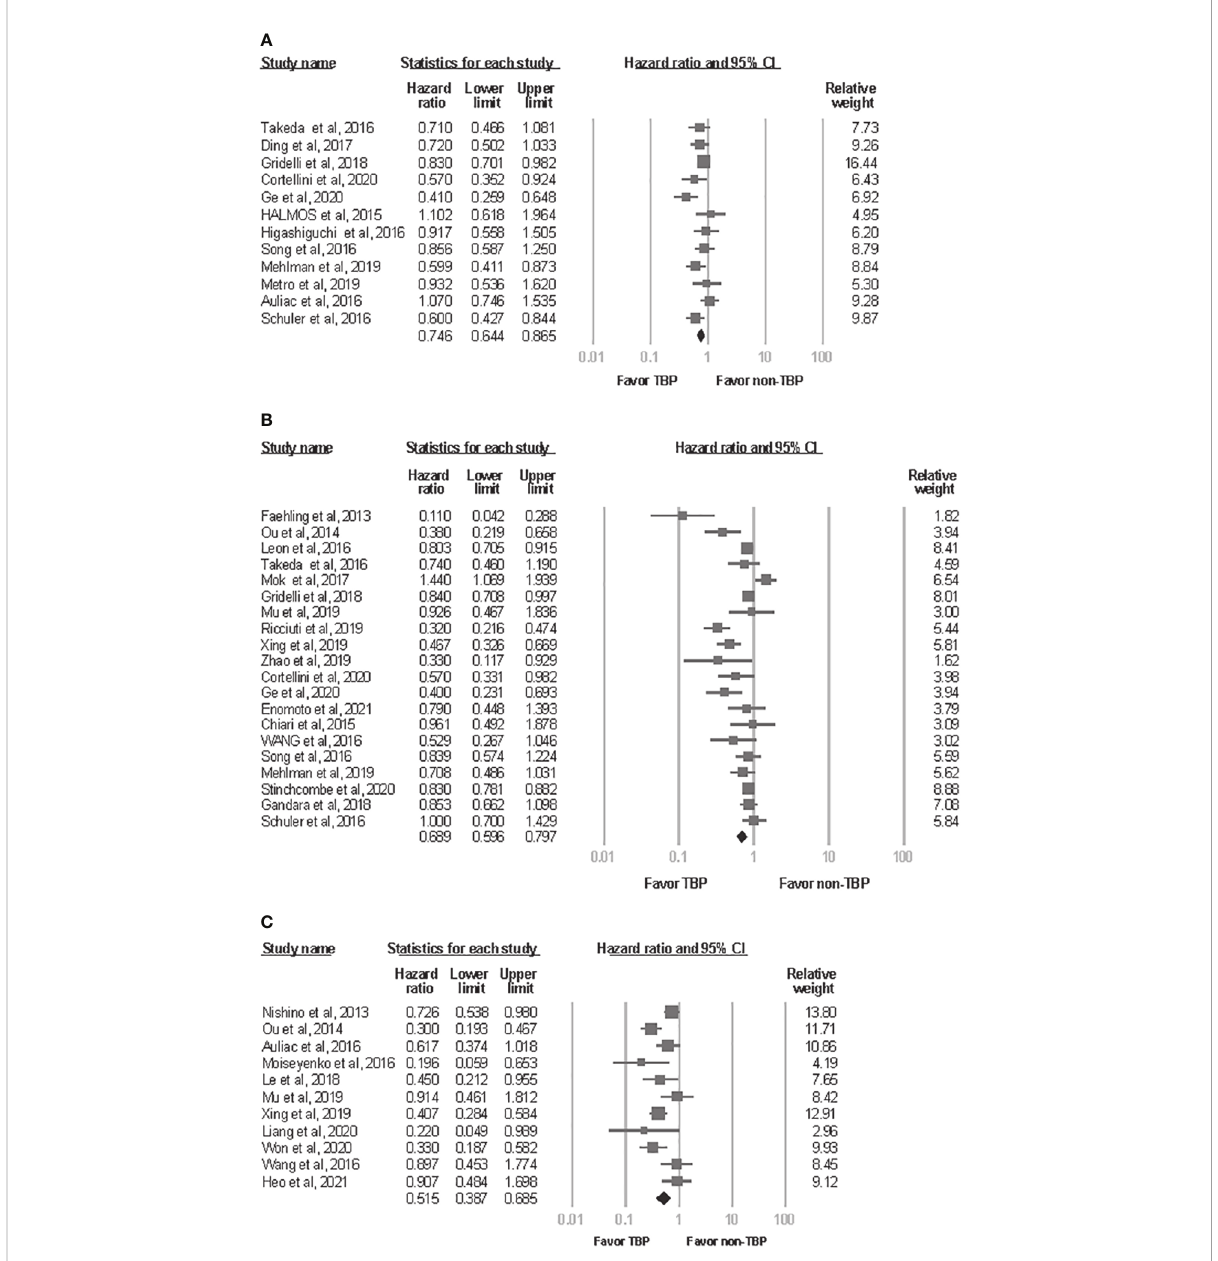
FIGURE 2 Forest plot of meta-analysis for effects of treatment beyond progression on survival outcome of NSCLC patients. (A) post progression progression-free survival. (B) post progression overall survival. (C) overall survival from initiation of drugs. CI, con fi dence interval; TBP, treatment beyond